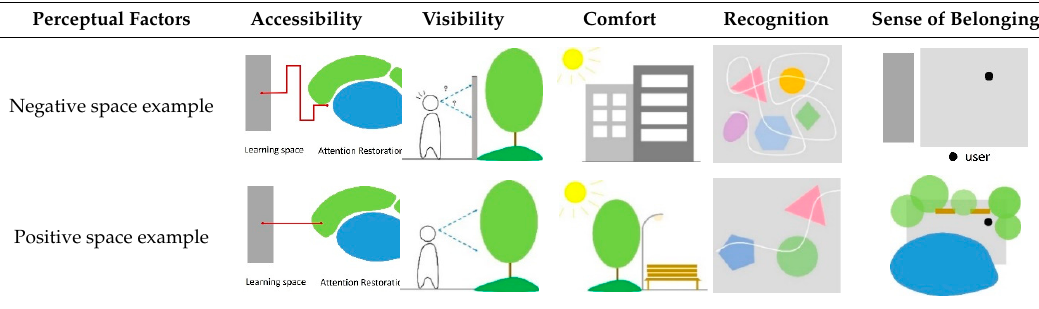
Table 5. Primary perceptual factors design diagram of the attention restoration space.